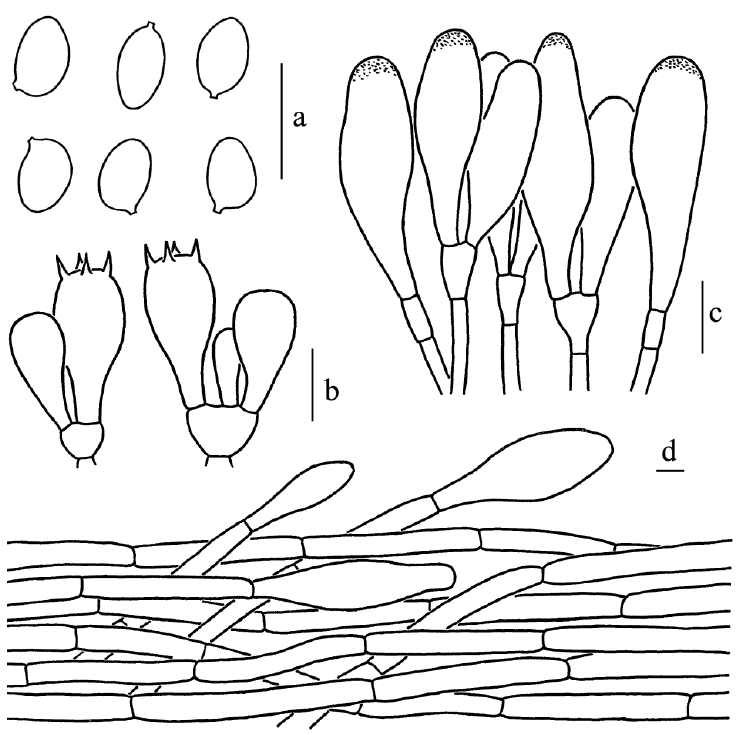
Figure 11. Leucoagaricus centricastaneus (SYAU FUNGI 076). ( a ) Basidiospores. ( b ) Basidia. ( c ) Cheilocystidia. ( d ) Elements of pileus squamules. Scale bars: 10 μm. Diagnosis: Leucoagaricus centricastaneus is characterized by its pileus with orange–